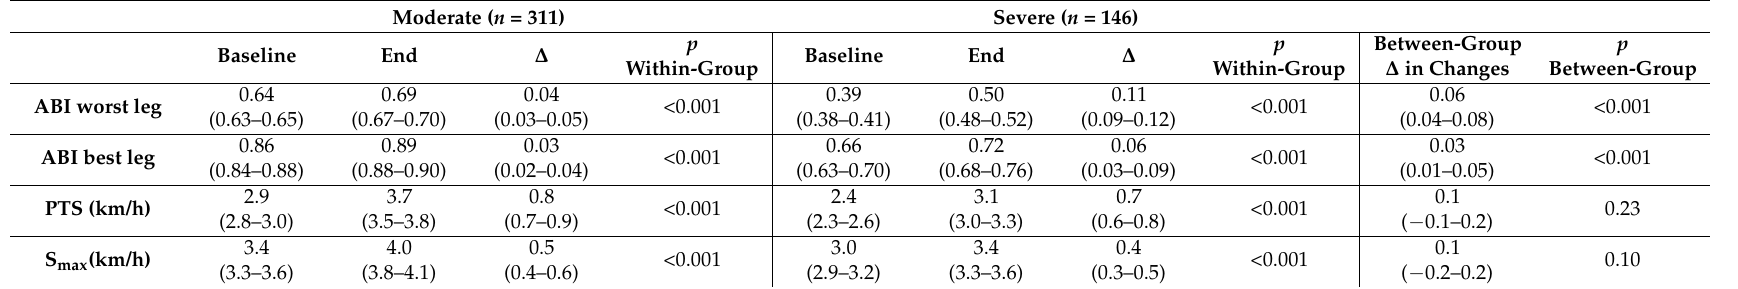
Table 2. Within- and between-group differences in rehabilitation